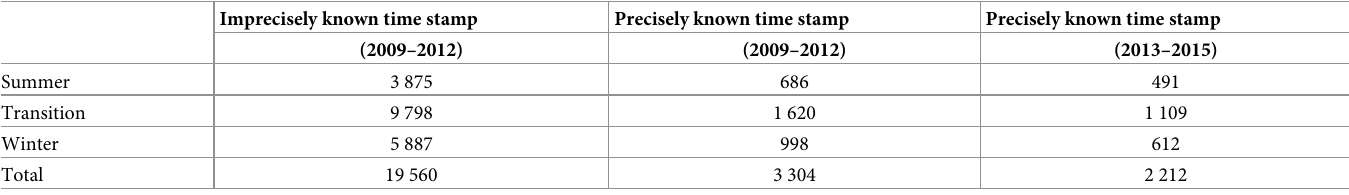
Table 1. Seasonal structure of the study dataset of apartment burglaries in Vienna,